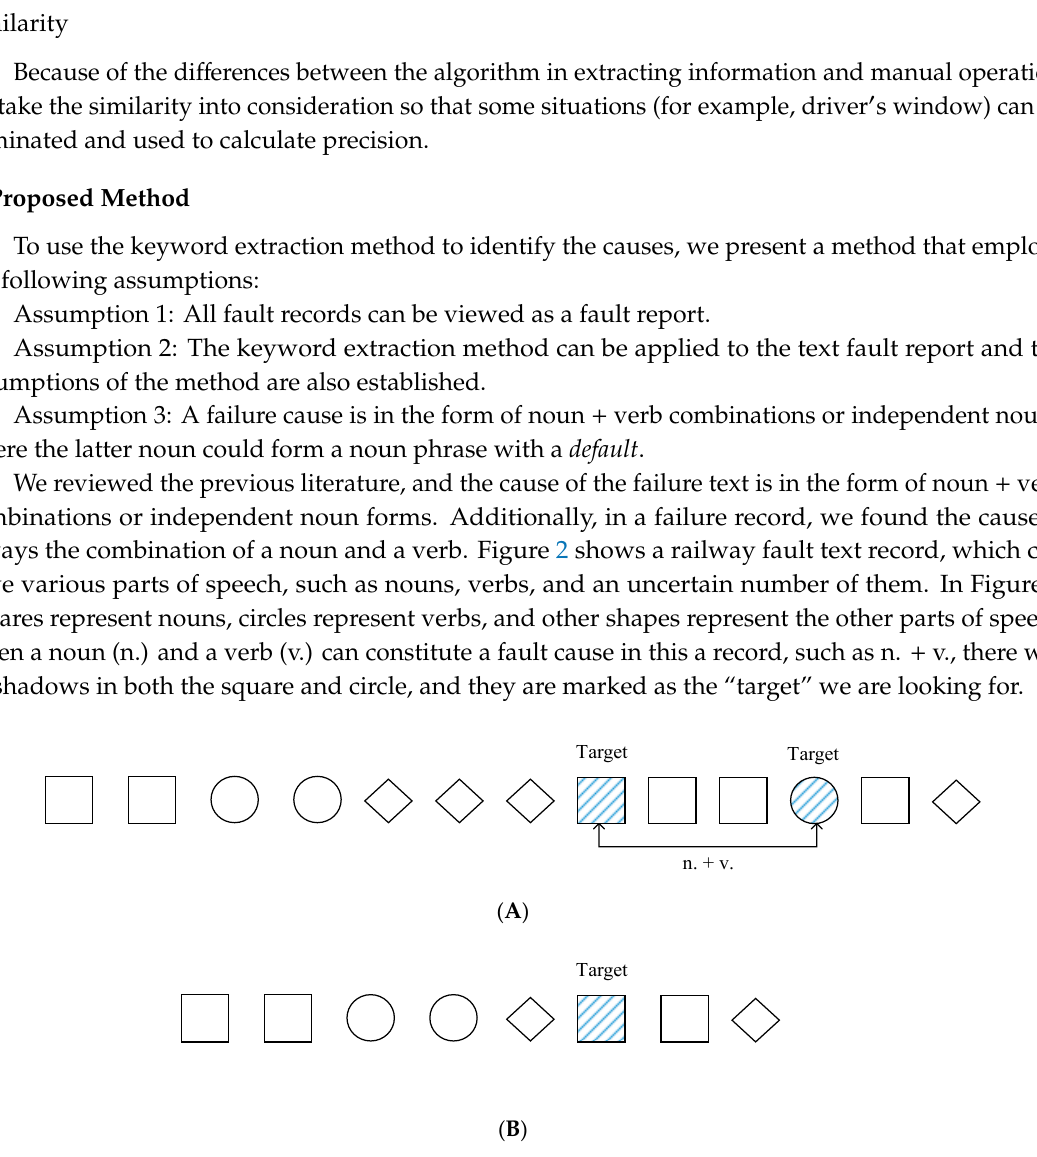
Figure 2. ( A ) A failure record with a combination target noun + verb (n. + v.). ( B ) A failure record with an insolate target (noun). Squares represent nouns, circles represent verbs, and other shapes represent the other parts of speech.